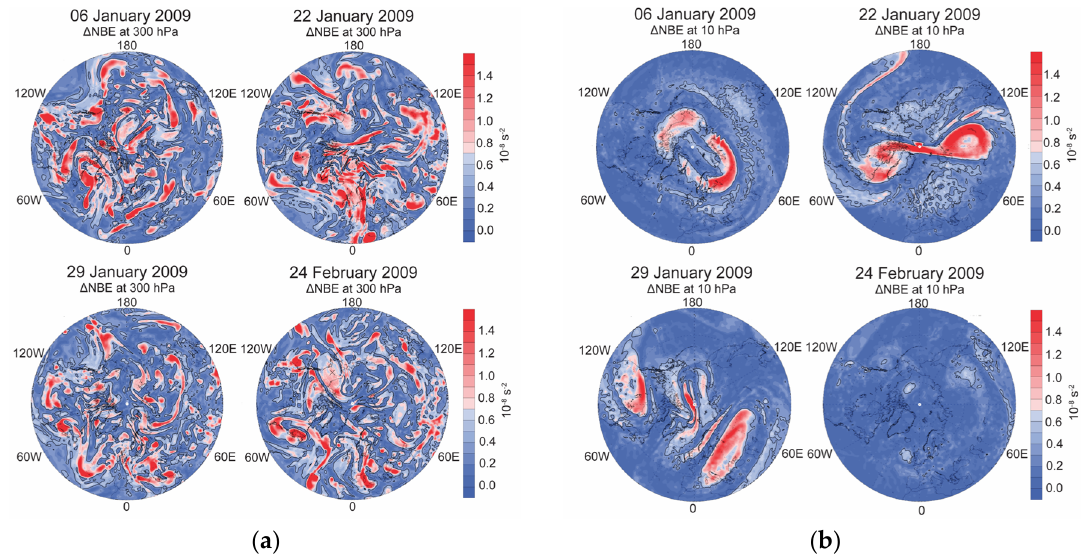
Figure 8. MERRA nonlinear balance equation ( Δ NBE ) plotted in false color for four days in January and February 2009 at ( a ) 300 hPa (~9 km) and ( b ) 10 hPa (~31 km). The solid line is the 0.4 × 10 − 8 s − 2 contour.